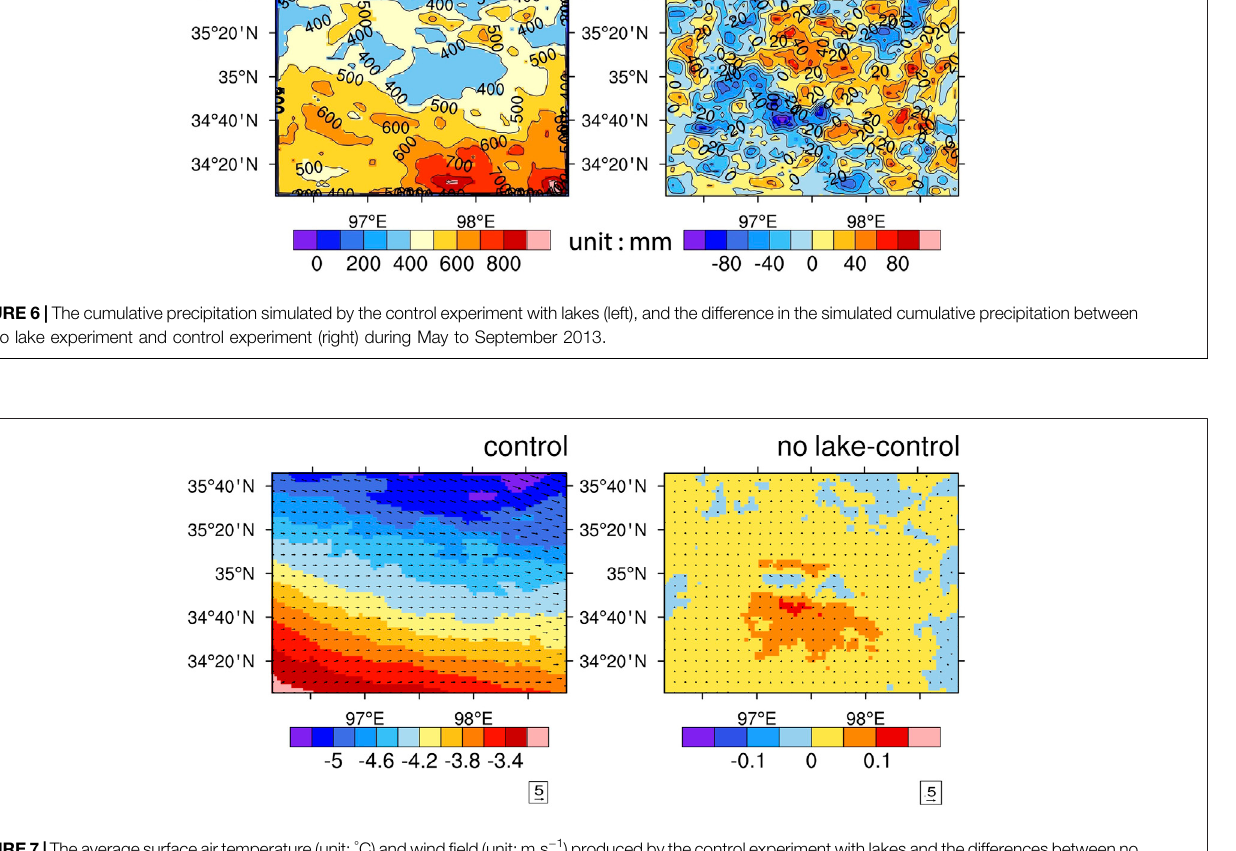
FIGURE7| Theaveragesurfaceairtemperature(unit: ° C)andwind fi eld(unit:m s − 1 )producedbythecontrolexperimentwithlakesandthedifferencesbetweenno lake experiment and the control experiment during May to September 2013.